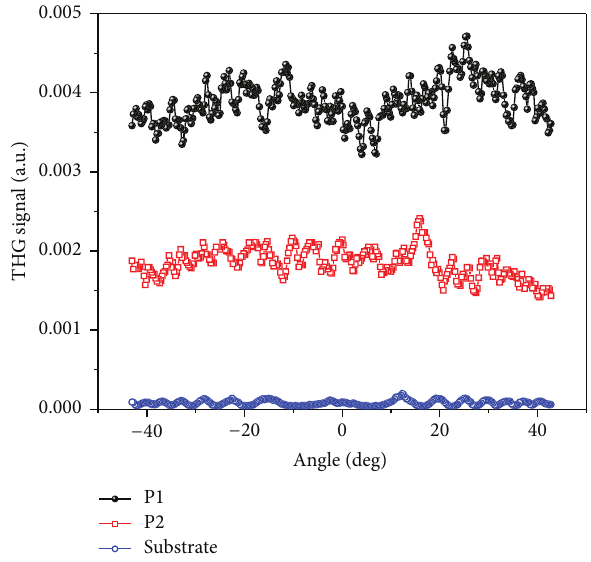
Figure 6: THG Maker-Fringe pattern from thin films (433 nm) of copolymers P1 and P2 deposited in a 1mm thick glass substrate. As reference,thefigureincludestheTHGsignalfromasubtratewithout a film deposited on